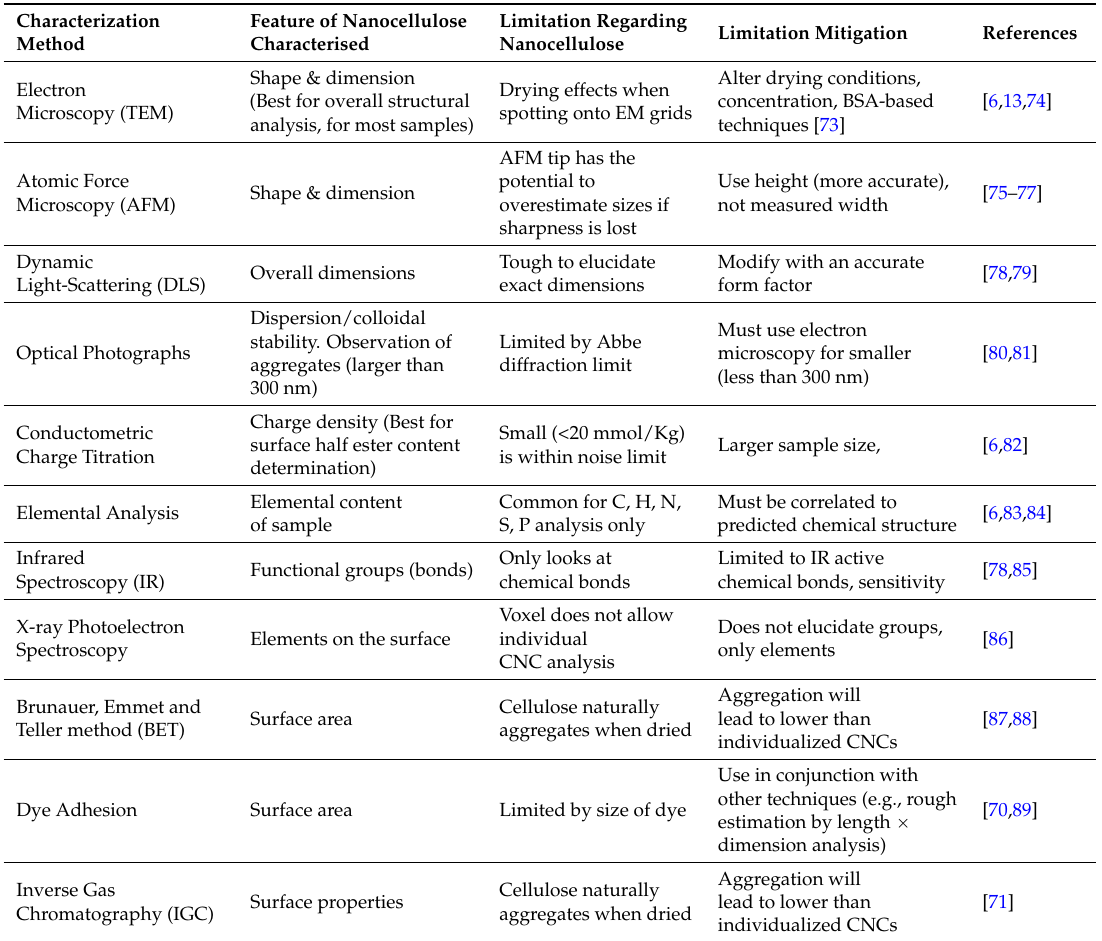
Table 1. Overview of the most commonly used analytical methods for the characterization of the physico-chemical properties of nanocellulose, in particular CNCs. Details as to the limitations of each method, with concepts towards mitigation of such limitations also